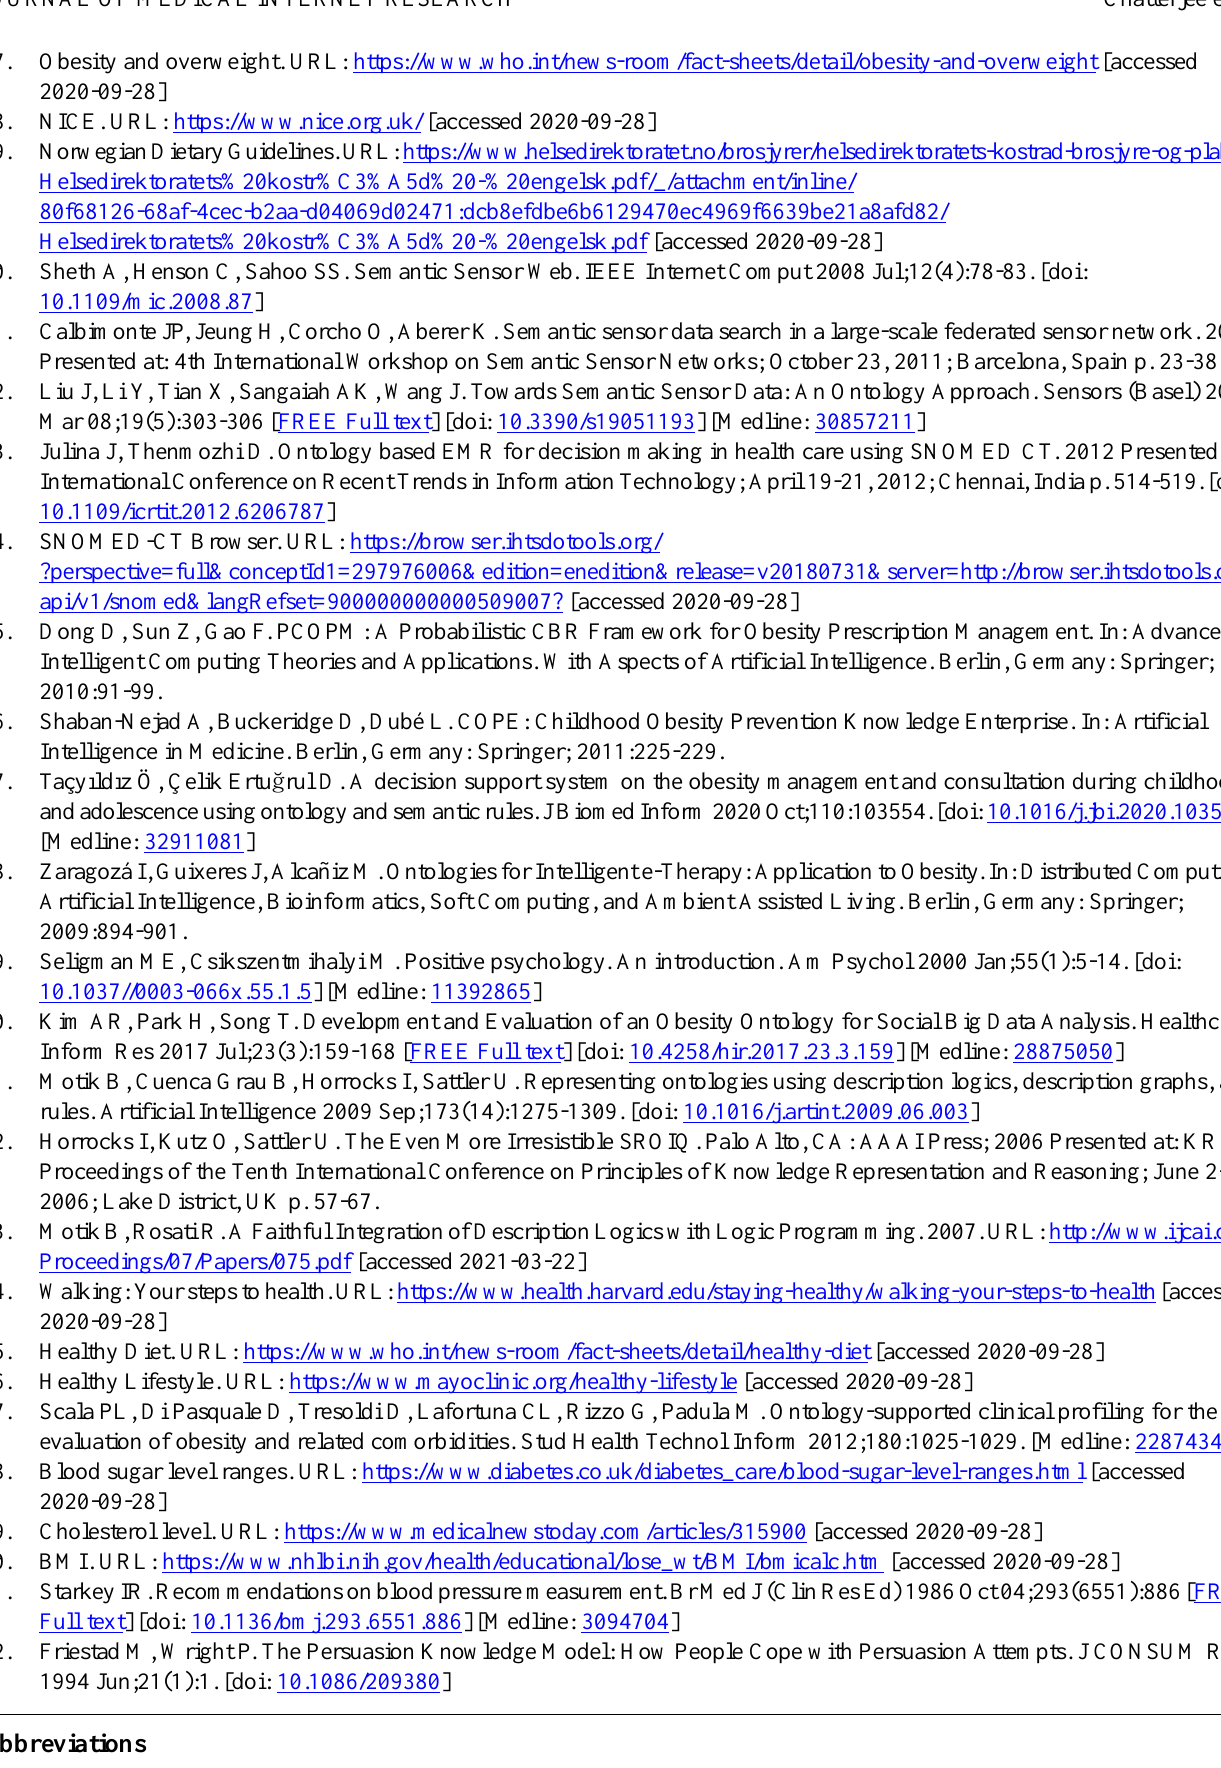
Abbreviations AI: artificial